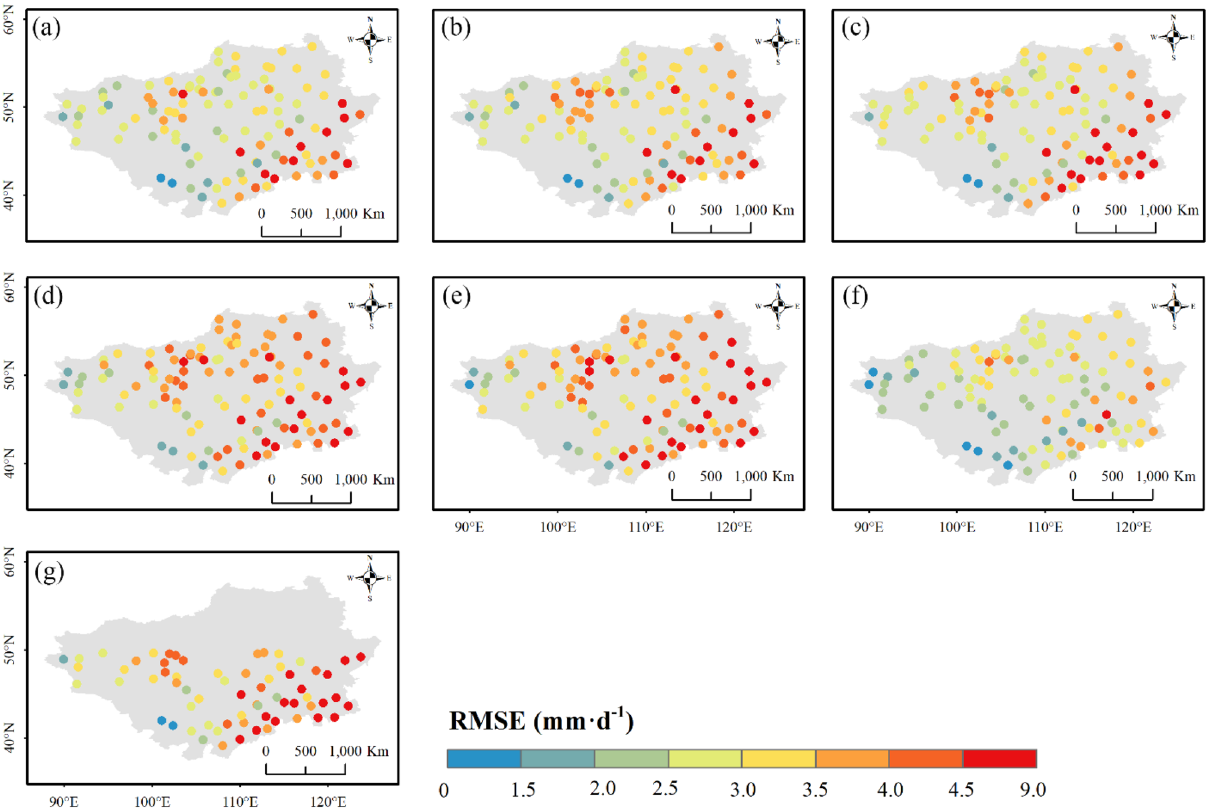
Figure 11. Spatial distribution of RMSE for ( a ) ERA5-Land, ( b ) ERA5-HRES, ( c ) ERA-Interim, ( d ) IMERG ER, ( e ) IMERG LR, ( f ) IMERG FR, and ( g ) TMPA-3B42. For subplot ( g ), only stations within the spatial coverage of TMPA-3B42 (50° N–50° S) were plotted. The figure was created using ArcGIS 10.7 (https:// www. esri. com/ en- us/ arcgis/ about- arcgis/ overv iew) 70